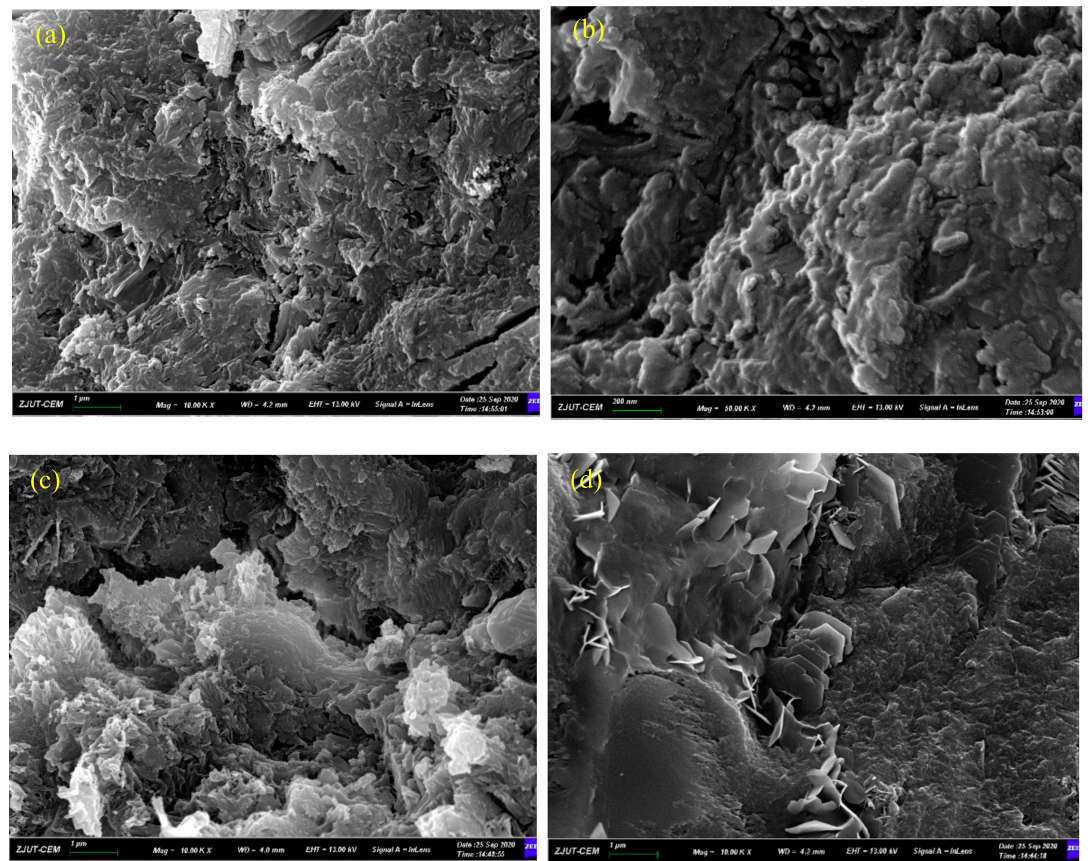
Figure 10. Scanning electron microscope images of 28 days sample. ( a , b ) Samples without nano-MgO; ( c , d ) Samples mixed with 6%